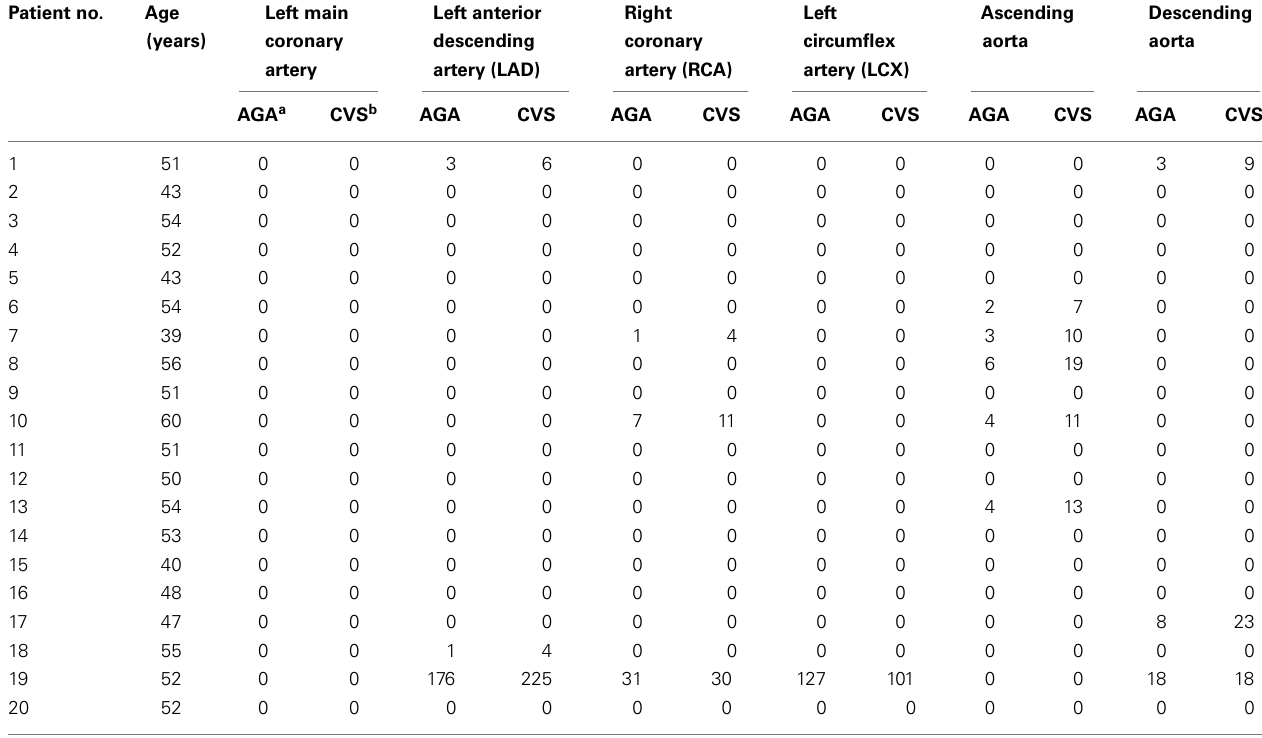
Table 2 | Electron beam CT calcium scores. Patient